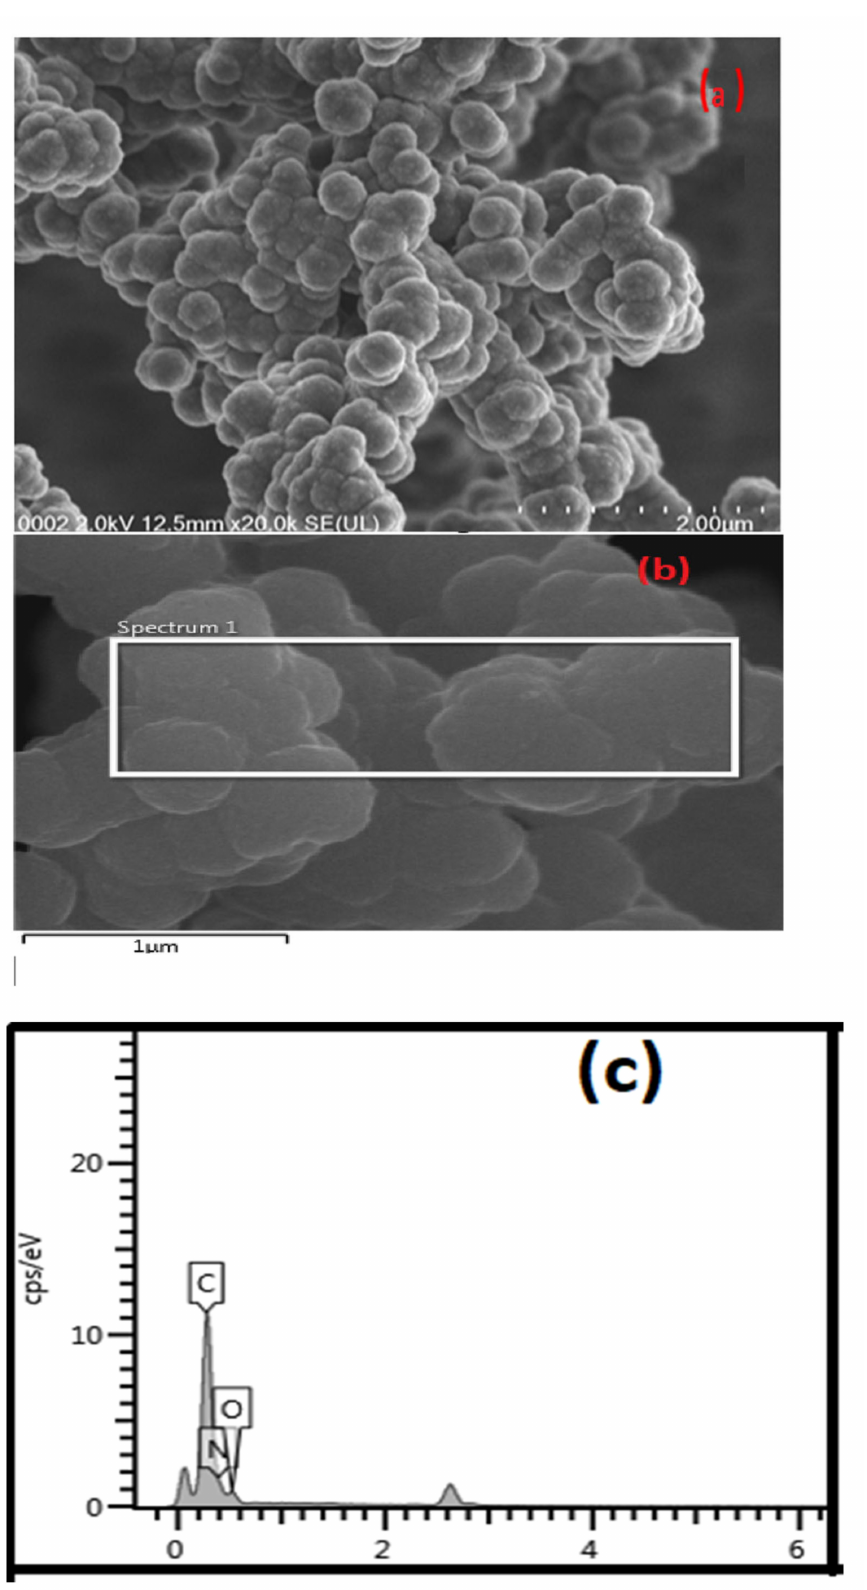
Figure 5. FESEM image of ( a ) PPy-PEI before and ( b ) EDX image of prepared PPy-PEI; ( c ) EDX graph showing elemental analysis of prepared